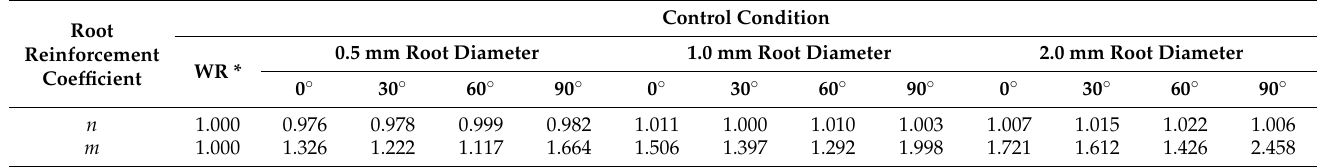
Table 4. Root reinforcement coefficients of unreinforced soils and root-soil